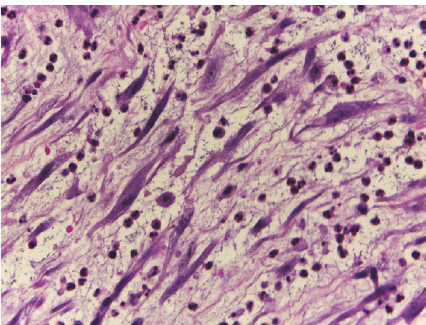
Figure 2: Histological examination (hematoxylin-eosin staining; magnification 10 × 40), showing spindle cell proliferation with a fascicular pattern admixed with inflammatory cells on a myxoid background.